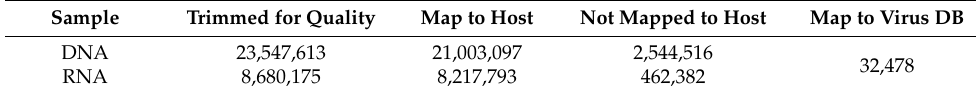
Figure 7. Correlation matrix comparing bacteria and bacteriophage taxa at the family level. Node diameter corresponds to level of correlation. Node color corresponds to the Pearson correlation coefficient and ranges from -1 to 1 indicated by red and blue, respectively. Table 3. Sequencing data generated by DNA-Seq and RNA-Seq for samples from diseased birds.